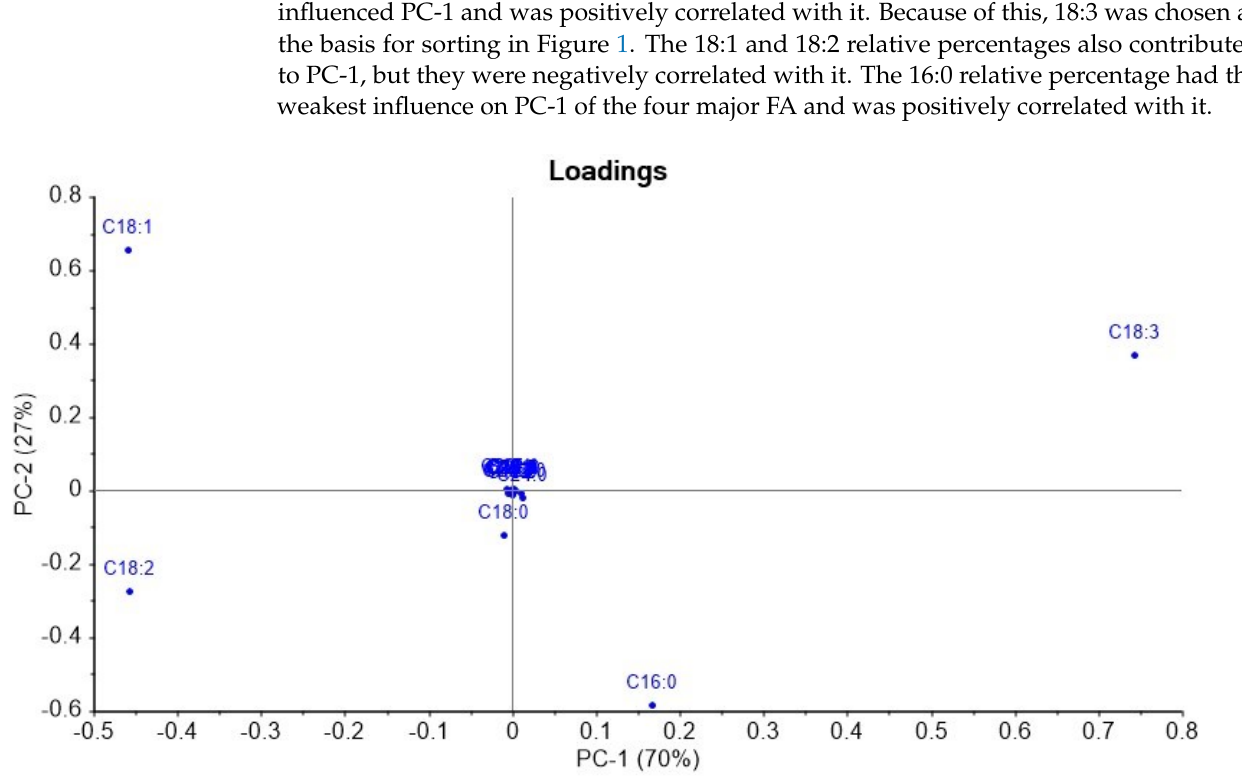
Figure 3. Loadings plot from Principal Component Analysis of the complete FA compositions by C:U (carbon number: unsaturation) of the ten pulse